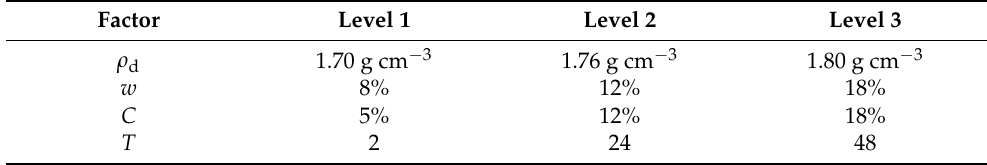
Table 1. Experimental factors and their levels.